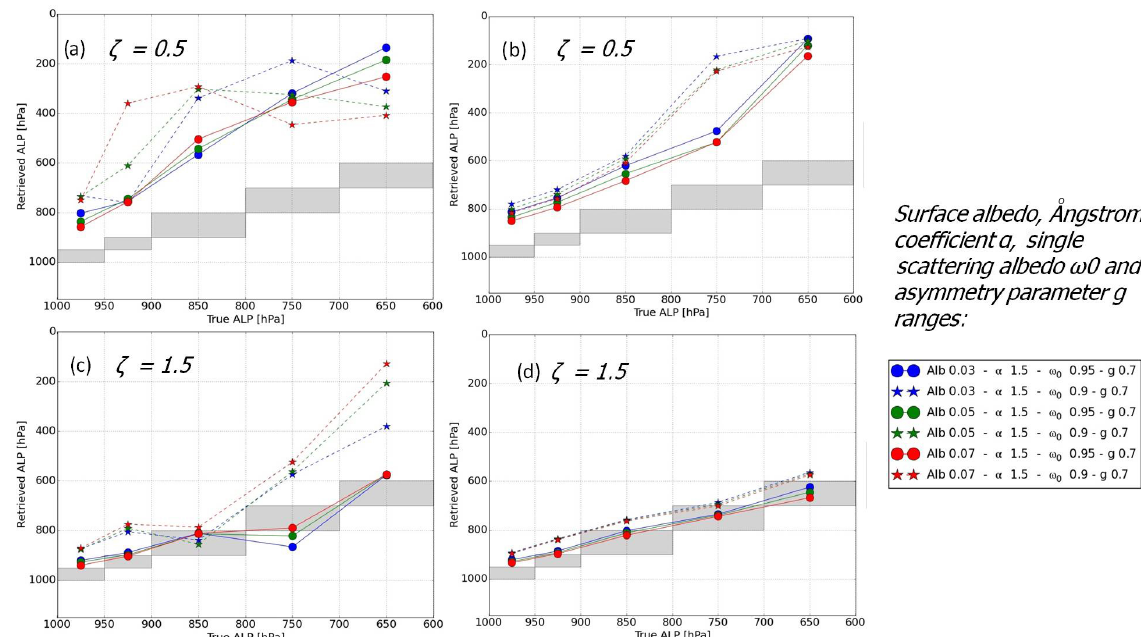
Figure 6. Simulated ALP retrievals vs. true ALP for 2 τ values (0.5 and 1.5) and the two NN configurations (see Sect. 3.1) and for the following conditions: temperature, H 2 O, O 3 and NO 2 from climatology mid-latitude summer, θ 0 = 25 ◦ , θ = 25 ◦ , surface pressure of 1010hPa and fine scattering aerosol particles ( α = 1.5, ω 0 = 0.95, g = 0.7): (a) NN R true τ( 550nm ) value as input and τ( 550nm ) = 0.5; (c) NN R input and τ( 550nm ) = 1.5.